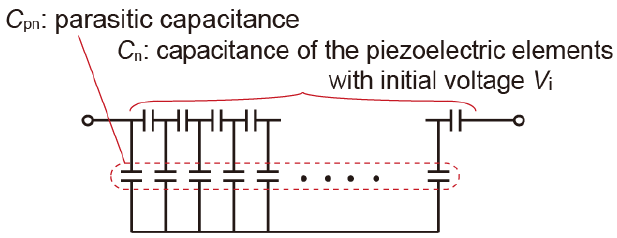
Figure 4. Equivalent circuit model of the series-connected piezoelectric elements. The piezoelectric elements are modeled as simple capacitors with initial